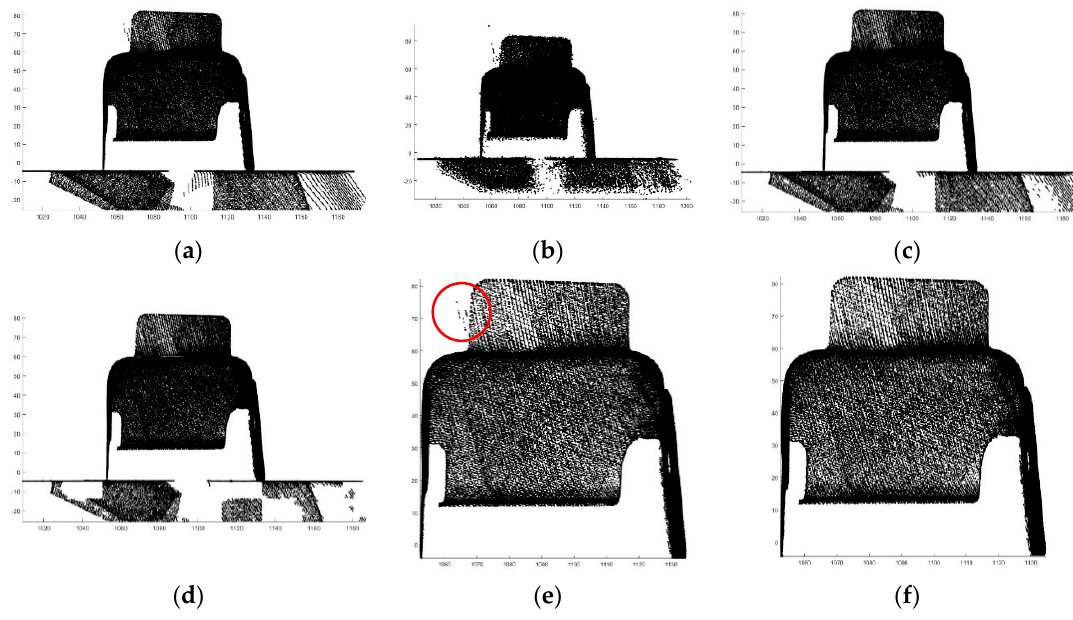
Figure 5. Point cloud denoising experiment. ( a ) is the initial point cloud data, ( b ) is the calculation result of Laplace filtering, ( c ) is the calculation result of neighborhood filtering, ( d ) is the calculation result of statistical filtering, ( e ) is the calculation result of straight- through filtering, and ( f ) is the calculation result of hybrid filtering in this paper.